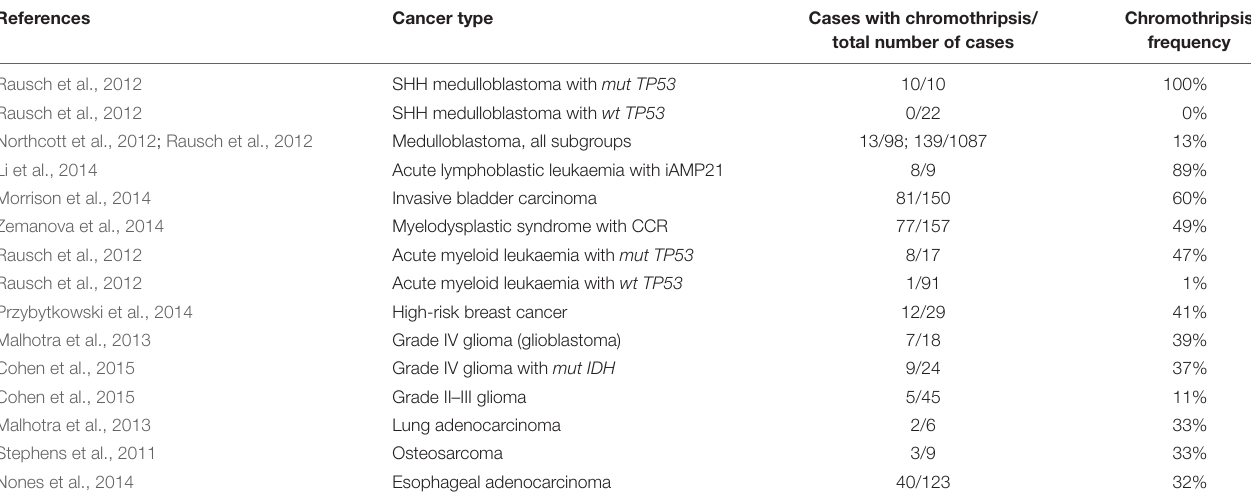
TABLE 1 | Types of cancer with the highest occurrence of